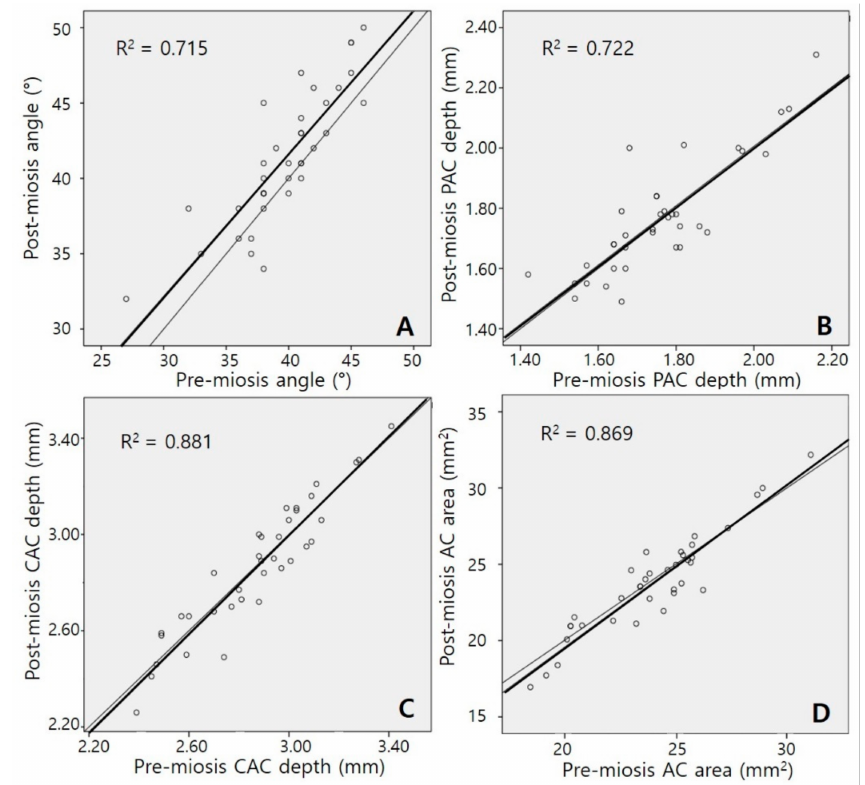
Figure 3. Scatter plots of anterior chamber (AC) parameters in the pseudophakia group. ( A ) AC angle, ( B ) peripheral anterior chamber (PAC) depth, ( C ) central anterior chamber (CAC) depth, and ( D ) AC area. Correlations between pre-miosis and post-miosis values in all parameters were positive and statistically significant (all p < 0.001). The thin line represents Y = X. Table 3. Distribution of patients stratified according to changes in anterior chamber structure after miosis.